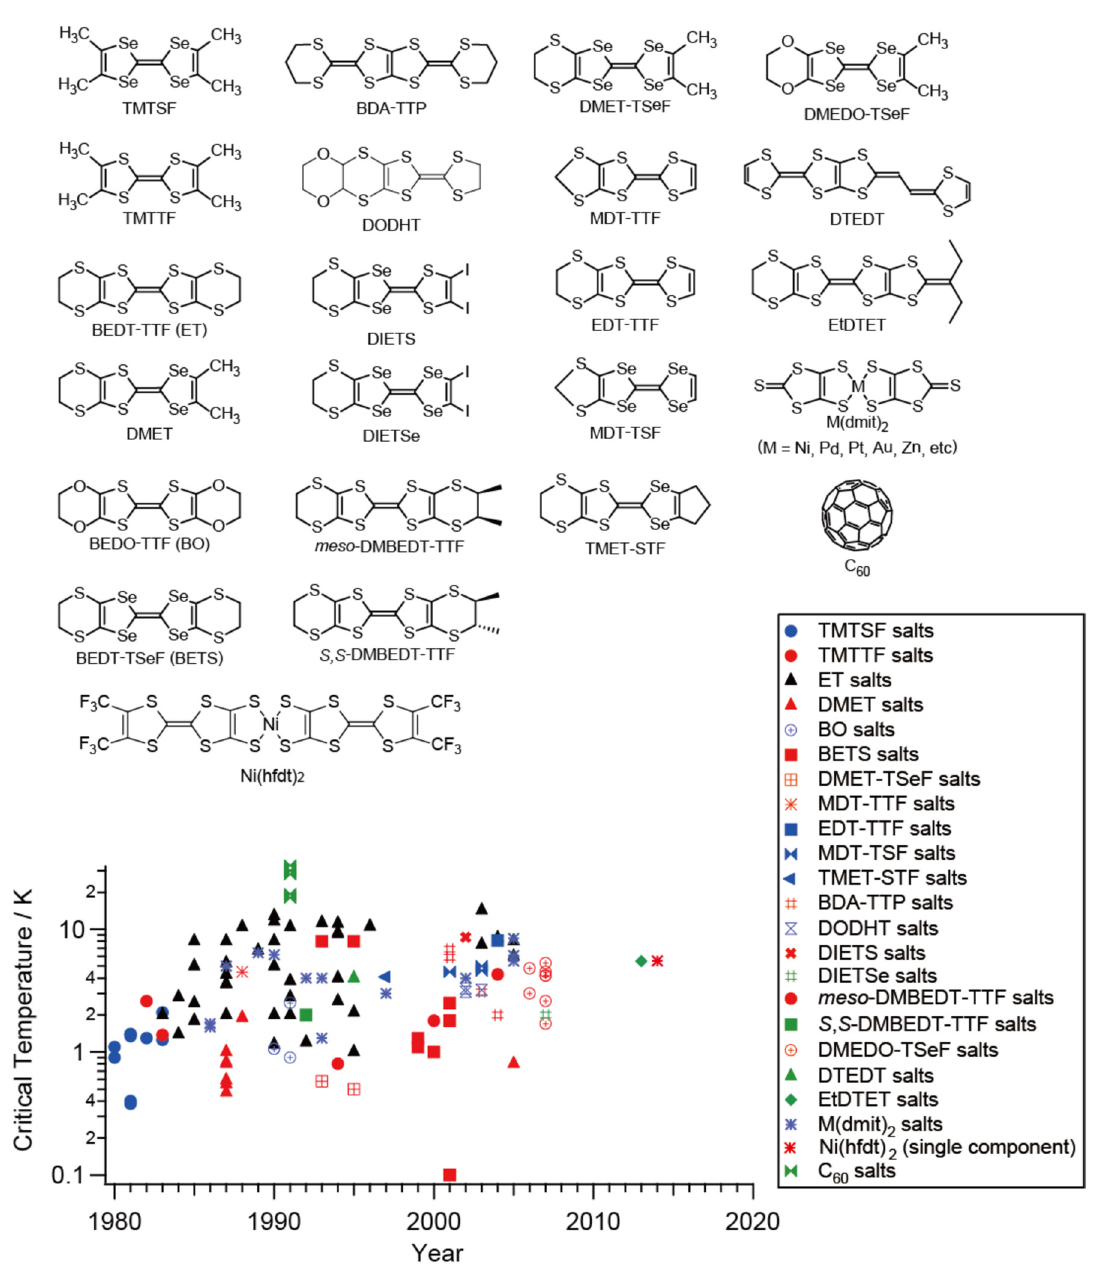
Figure 1. The history of the superconducting critical temperatures ( T C s) of organic and related conductors (not an exhaustive list). Note that all the component molecules, except for M(dmit) 2 and C 60 , belong to donor systems. Reproduced and modified from Ref. [21] with permission.